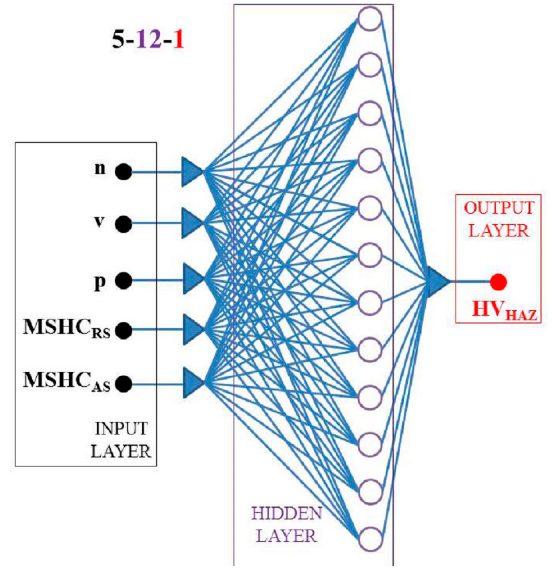
Figure 6. Back-propagation neural network used to foresee the Vickers micro hardness of the Heat Affected Zone (HAZ).